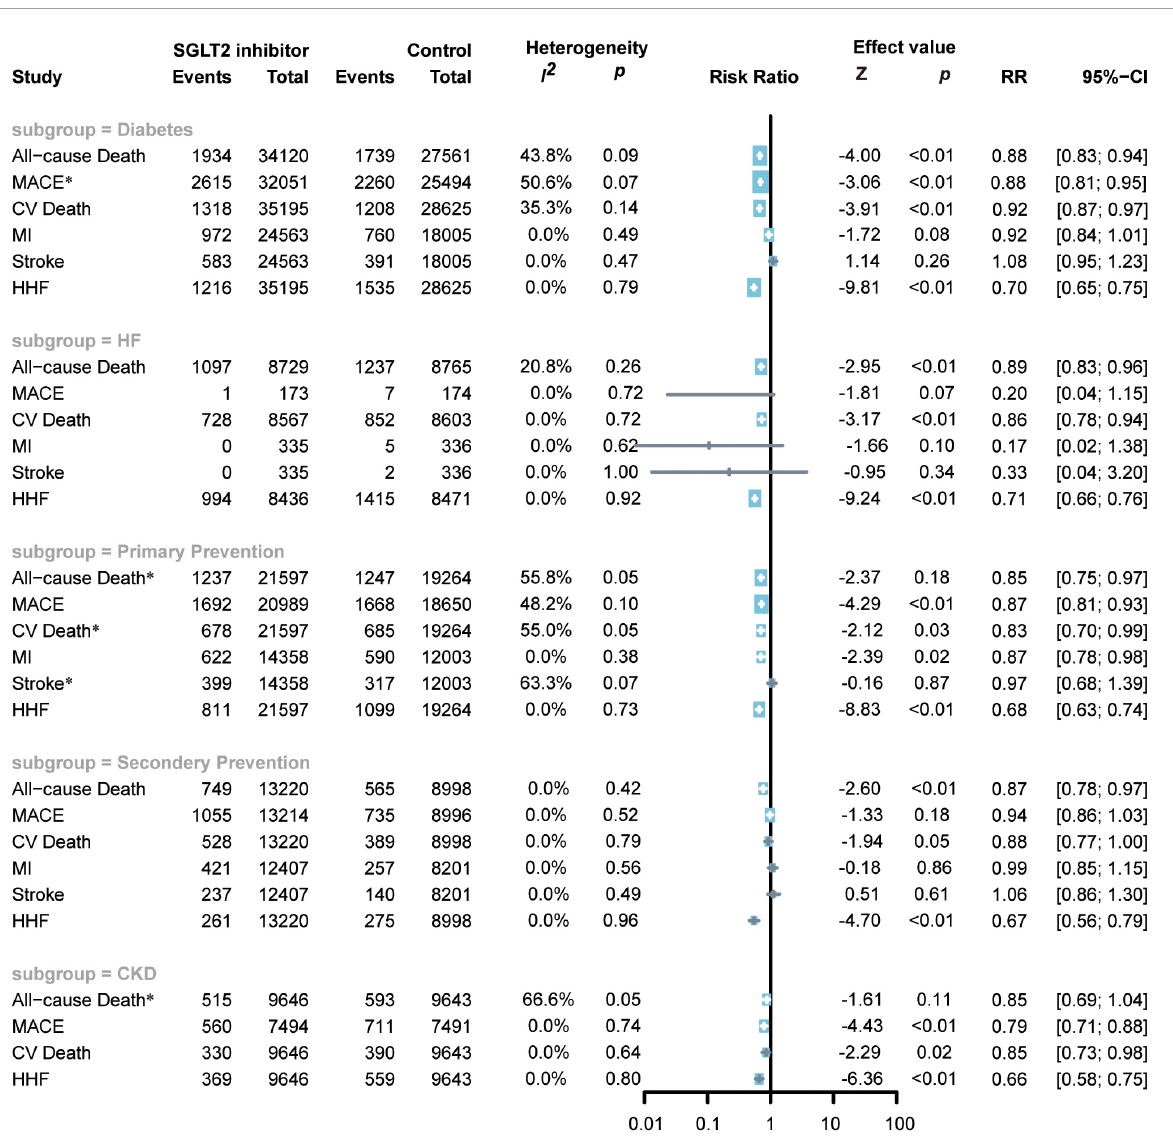
FIGURE5 Forest plot of subgroup of subjects with diabetes, HF, ACD, high risks of ACD, and CKD. SGLT2, Sodium-glucose cotransporter 2; MACEs, major adverse cardiac events; CV death, cardiovascular death, MI, myocardial infarction; HF, heart failure; HHF, hospitalization for heart failure. *Random-effects